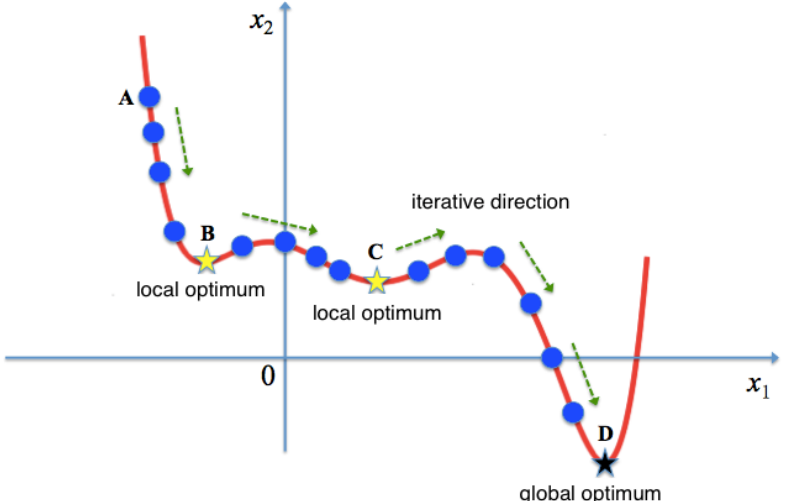
Figure 2. Simulated annealing